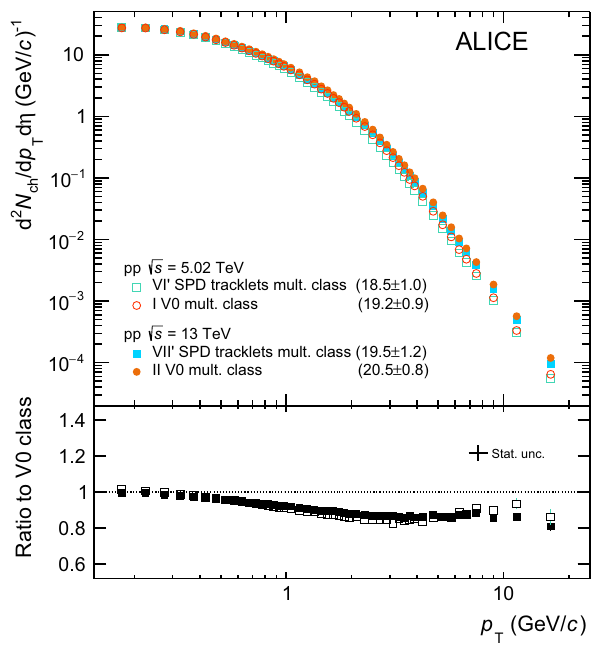
Fig. 4 Transverse momentum distributions of charged particles for √ s = 5 . 02 (empty high-multiplicity ( (cid:3) d N ch / d η (cid:4) ≈ 20) pp collisions at markers) and 13TeV (full markers). Results for V0-based (squares) and SPD-based (circles) multiplicity estimators are shown. The bottom panel shows the p T spectrum obtained using the V0-based multiplicity estimatornormalizedtothatusingtheSPD-basedmultiplicityestimator. √ Only statistical uncertainties are shown as error s = 5 . 02